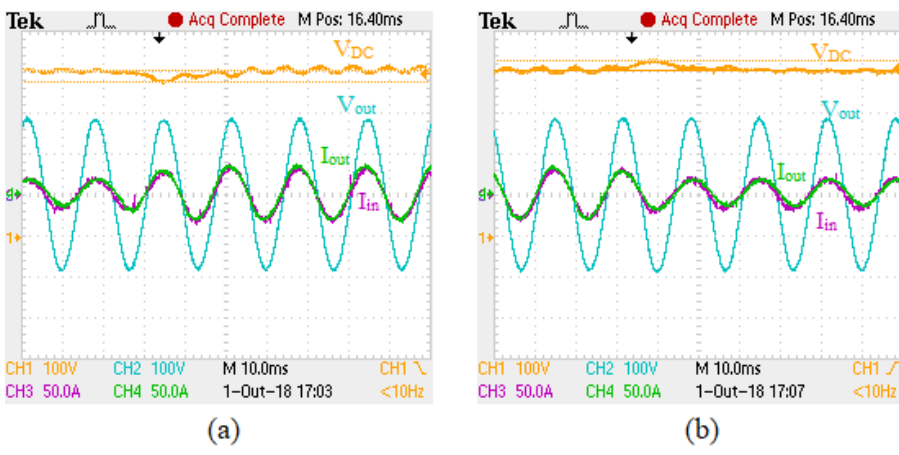
Figure 16. Dynamic behavior of the converter under load changes ( a ) − 25% load step ( b ) 25% load step. CH1: DC Link voltage, CH2: Output voltage, CH3: Input current, CH4: Output current.